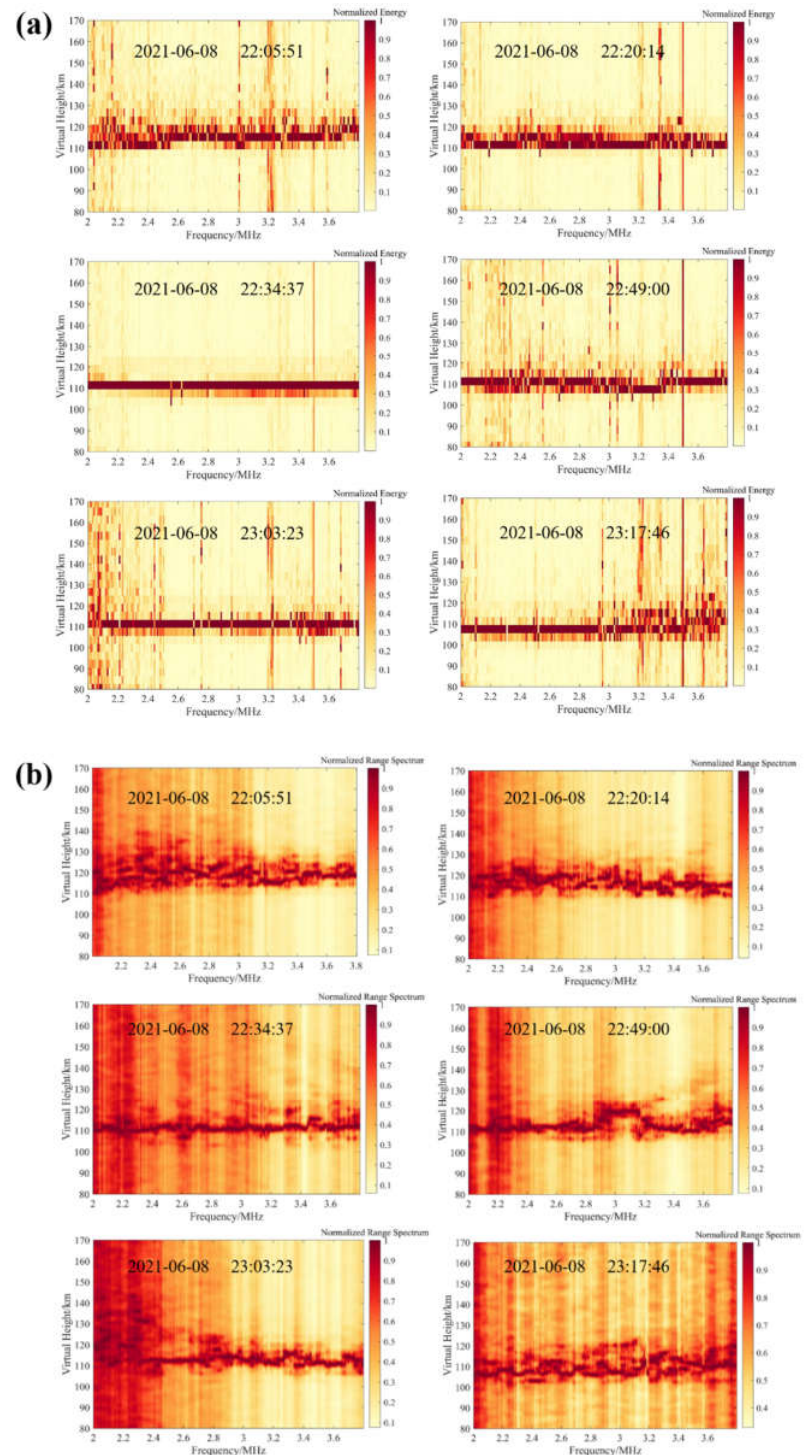
Figure 3. Drastic short-term evolution process of the Es layer within ~1 h. ( a ) Ionograms of the 3.84 km range resolution at ~22:06–23:18 LT (UTC+8) on 8 June 2021, with an interval of 15 min. Although obvious changes are observed in the Es layer, the details can hardly be observed. ( b ) Ionograms of the 38.4 m range resolution. The evolution details are clearly observed. The compression process of the Es layer proceeds at the same speed at each frequency; however, rediffusion starts at the high-frequency